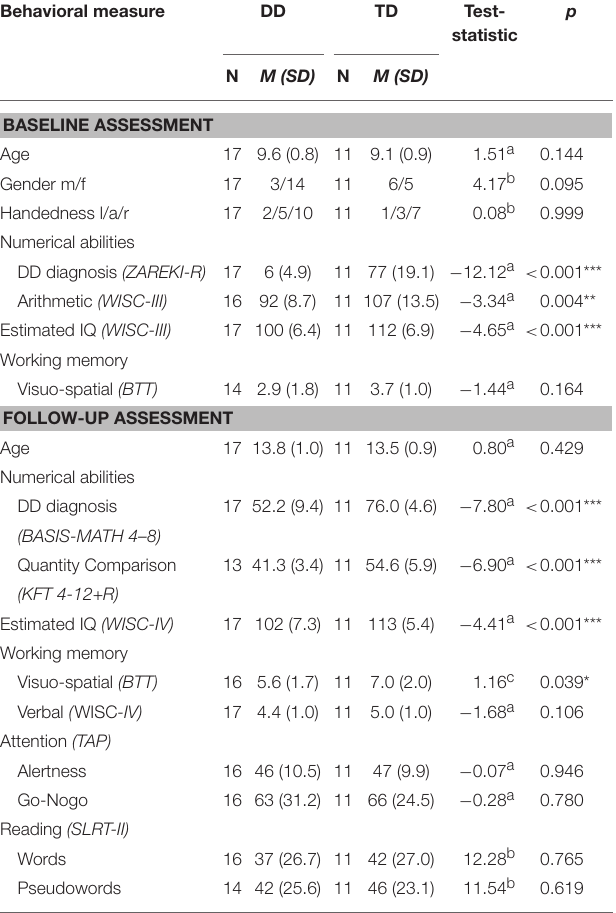
TABLE 1 | Demographic characteristics and scores on numerical abilities, intelligence quotient, working memory, attention, and reading. Behavioral